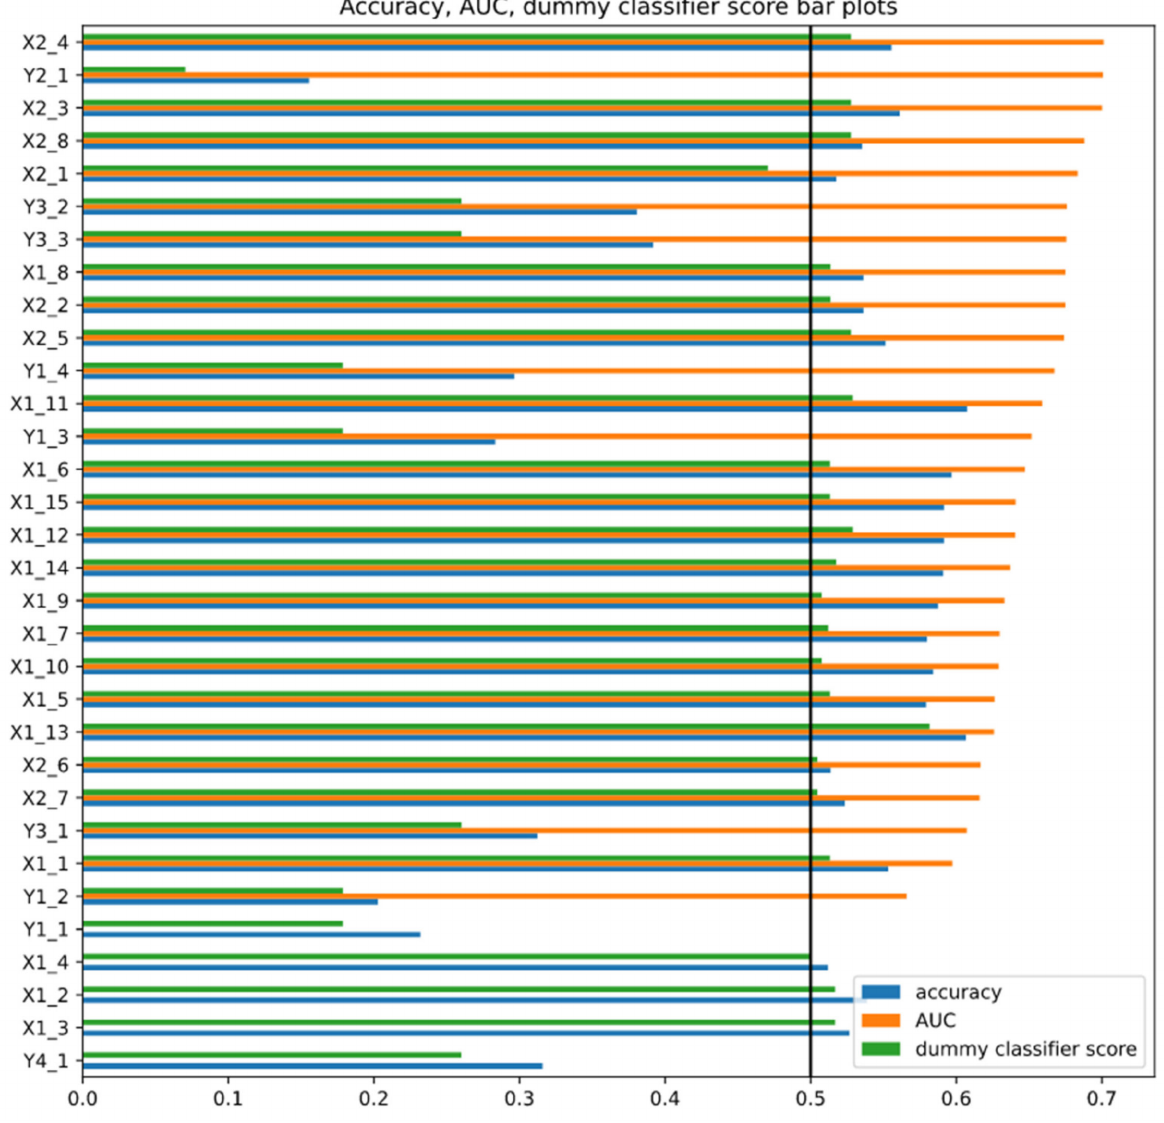
Figure 4. The accuracy, AUC, and dummy classifier scores of each model are sorted by AUC score. The black line indicates the value of AUC at which the model cannot discriminate classes. Some models do not have computed AUC